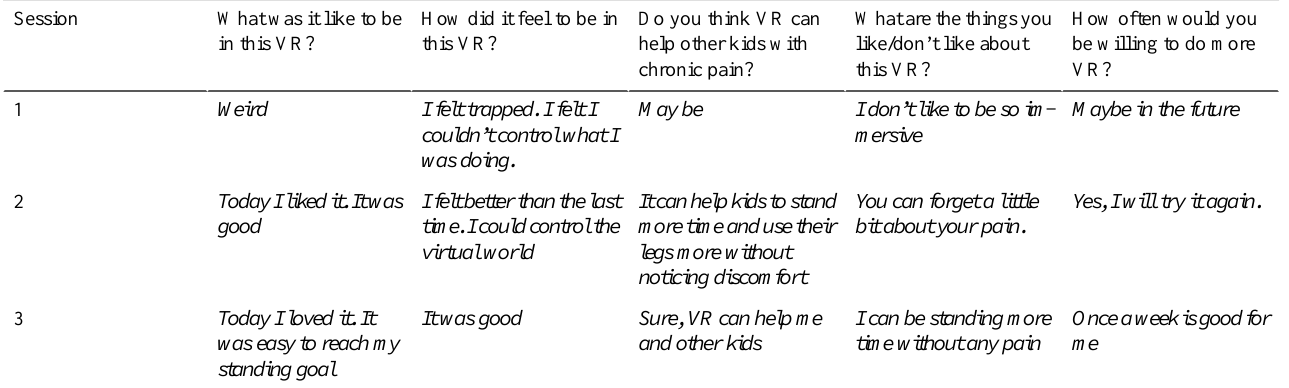
Table 2. Interview responses from one patient across multiple VR a